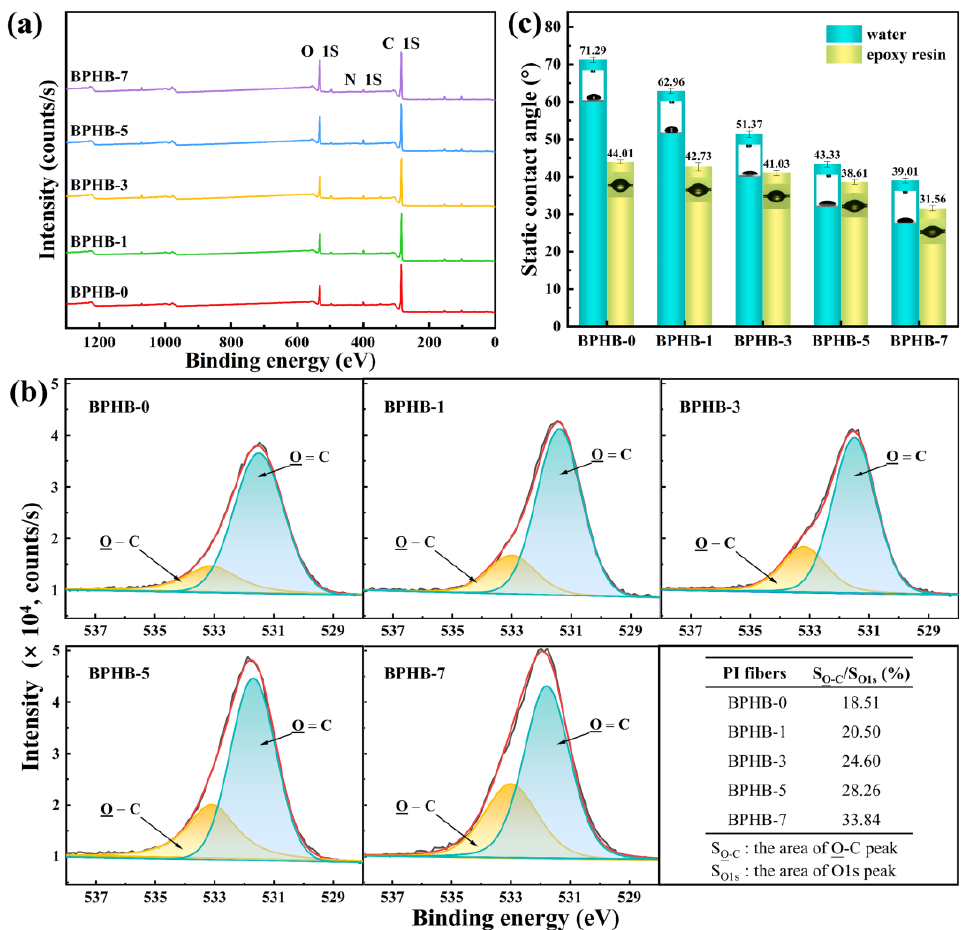
Figure 6. ( a ) XPS wide-scan spectra, and ( b ) curve-fitting O1s high-resolution XPS spectra for